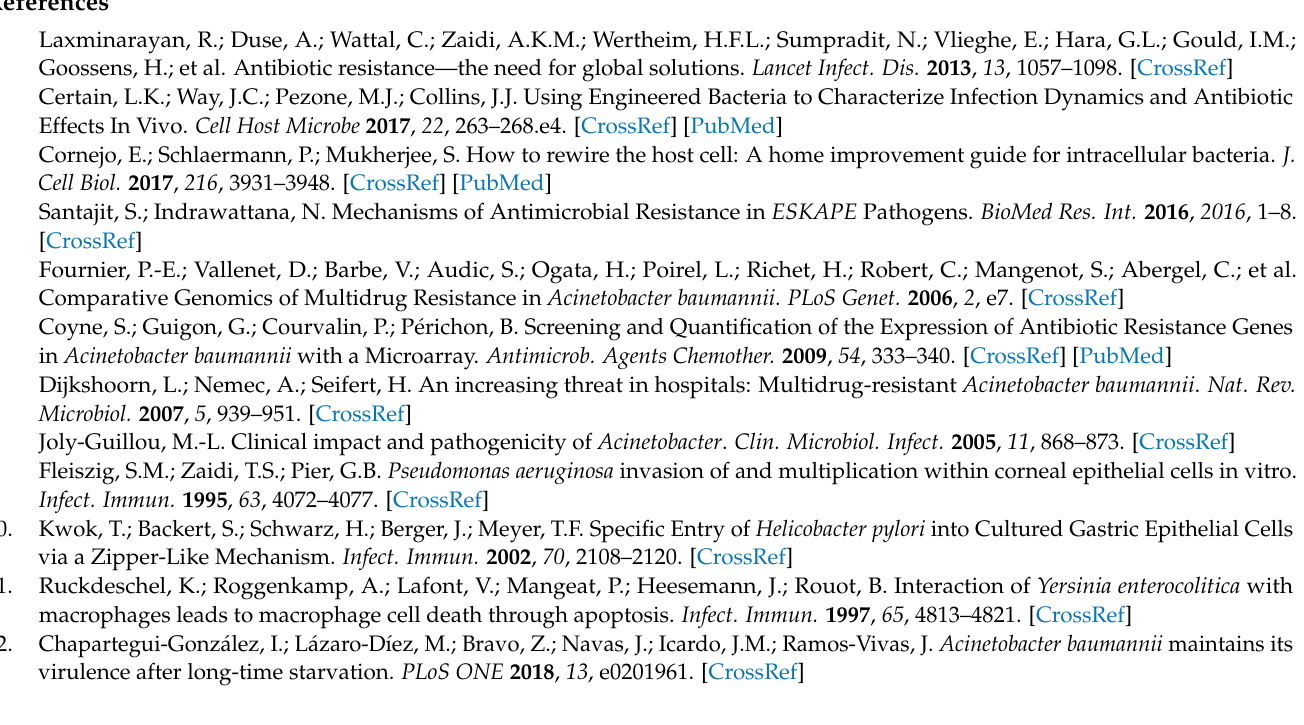
infection; Figure S2: Expanded representation of protein–protein interactions at 6 h post infection; Figure S3: Fold change correlation of DEGs identified during A. baumanni